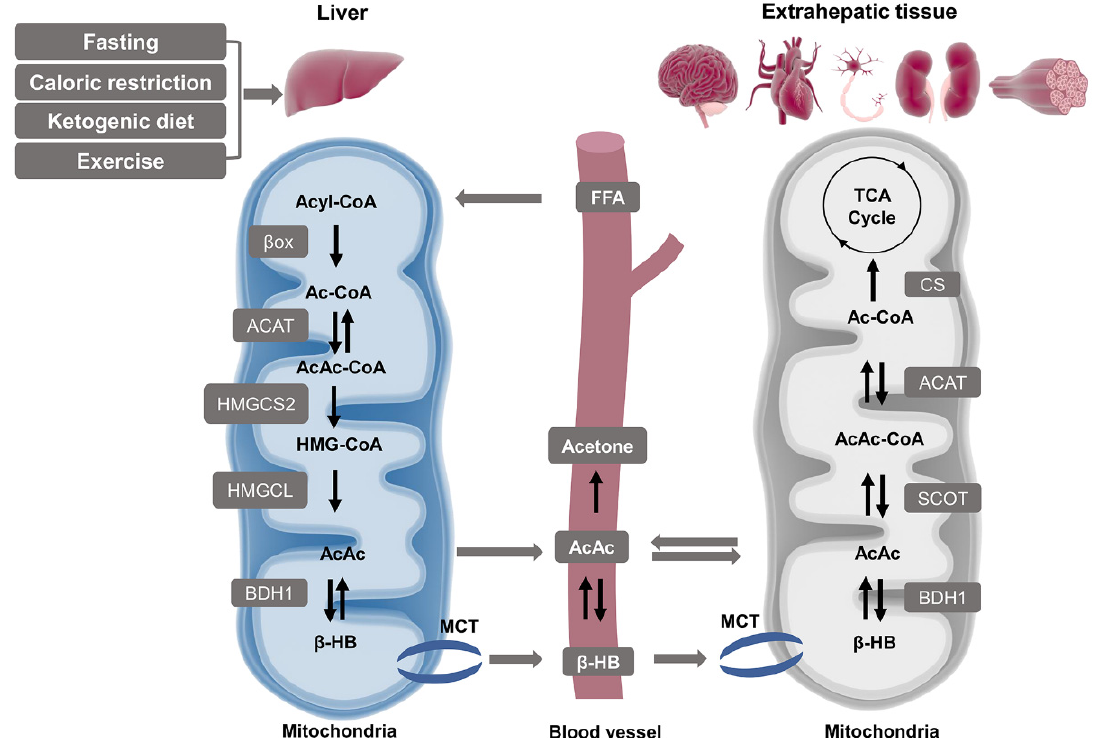
Figure 2. Pathways of ketogenesis in liver and ketolysis in extrahepatic tissues. Hepatic mitochondria act as the primary site for the synthesis of blood ketone bodies by using fatty acids-derived Ac-CoA which is generated by β oxidation. The following process requires four enzymes: ACAT, HMGCS2, HMGCL, and BDH1, and the intermediate product covers AcAc-CoA, HMG-CoA, and AcAc. β -HB is finally produced and released to the bloodstream and uptaken by extrahepatic tissues such as the brain, heart, neurons, kidneys, and muscles through MCT. Both β -HB and AcAc can be oxidized and converted to Ac-CoA and produce ATP via the TCA cycle as an alternative energy source. Abbreviations: AcAc, acetoacetate;